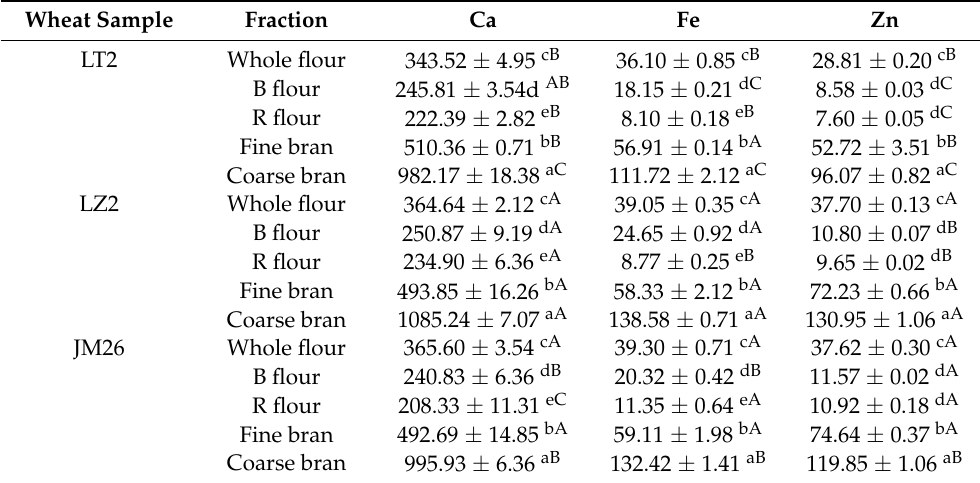
Table 4. Mineral composition (mg/kg) of milling fractions of LT2, LZ2, and JM26. Wheat Sample Fraction Ca Fe Zn LT2 Whole